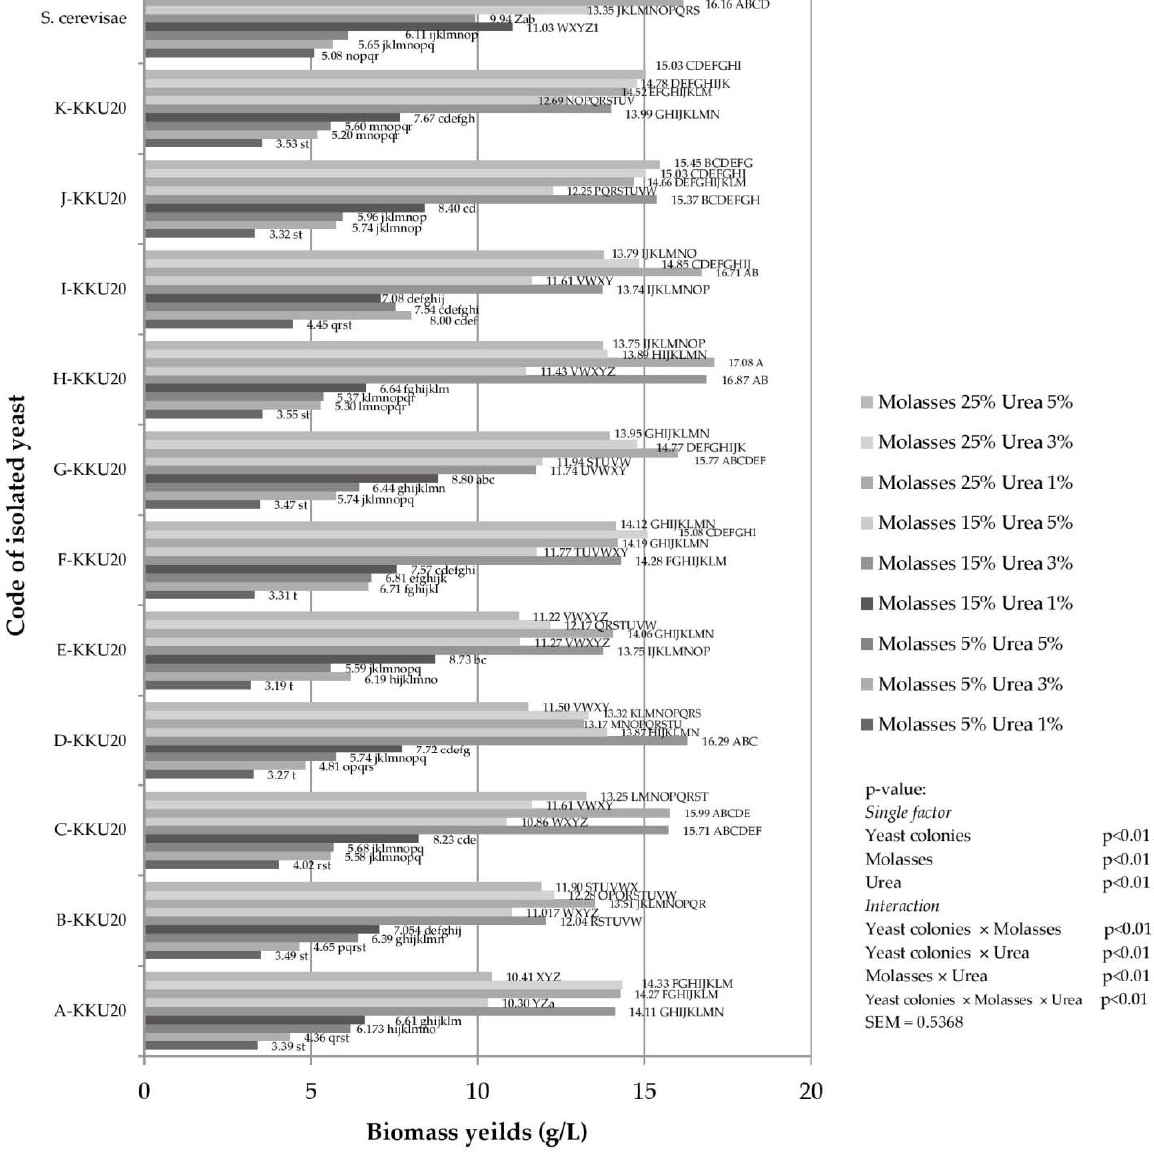
Figure 1. Biomass (horizontal axis) for yeast strains grown in different sugarcane molasses (5, 15 and 25%) with urea (1, 3 and 5%) for 72 h. A – Z,a – t Means with different superscript letters within bar chart are considered statistically significant ( p < 0.01), SEM = standard error of the mean, S. cerevisiae = Saccharomyce cerevisiae.